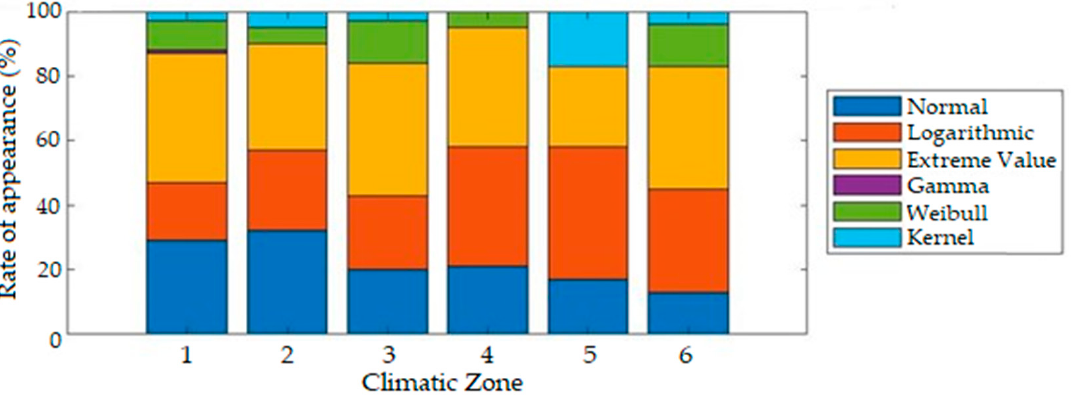
Figure 9. Bar chart with the rate of appearance of the PDFs in each month per climatic zone (DNI case). Source: own elaboration.